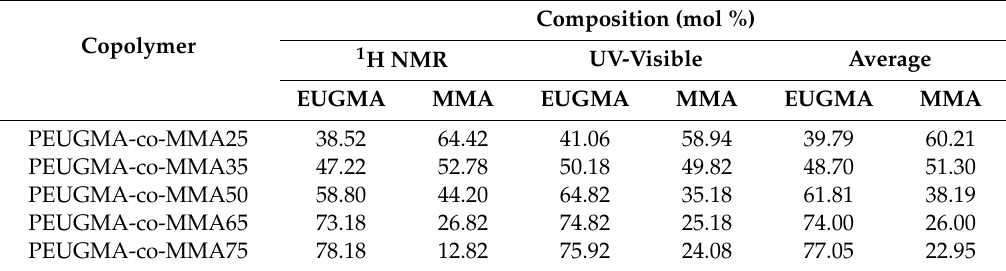
Figure 8. Comparative 13 CNMR spectra of PMMA, PEUGMA and PEUGMA-co-MMA25. Table 3. Comparative results of the copolymer compositions of PEUGMA-co-MMA determined by 1 HNMR and ultraviolet (UV)-visible methods.